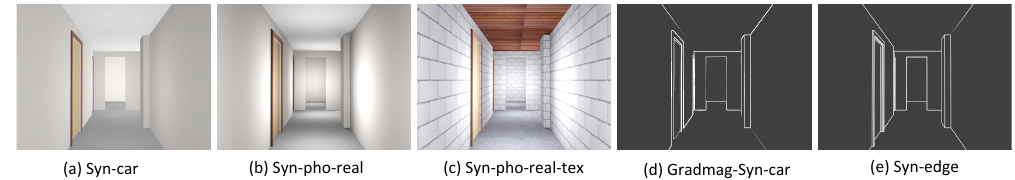
Figure 2. The five types of synthetic images generated from the 3D indoor model, after Acharya et al.